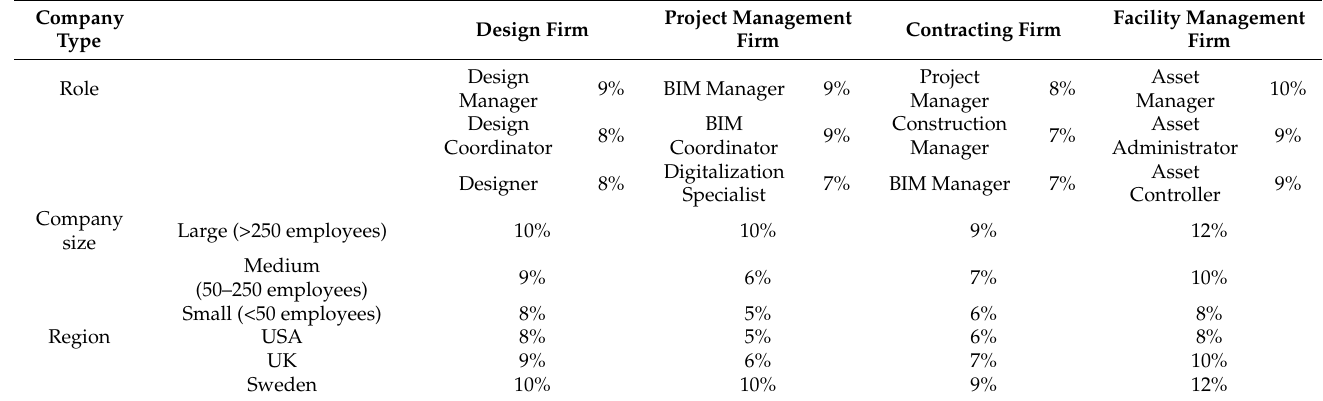
Table 3. Company region, size, and role in